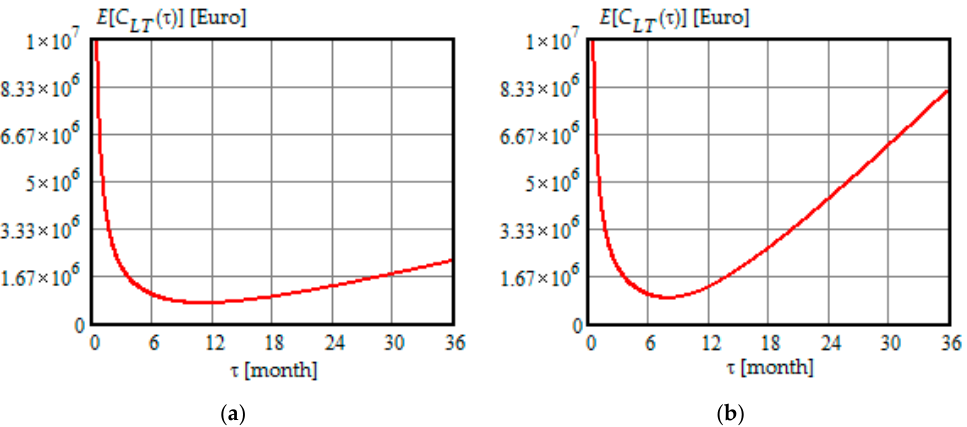
Figure 11. The dependence of the average lifetime maintenance cost on the periodicity of predetermined preventive maintenance when C UF = 72,000 : ( a ) Initiation crack rate is 0.05 [1 / year]; ( b ) Initiation crack rate is 0.2 [1/year].